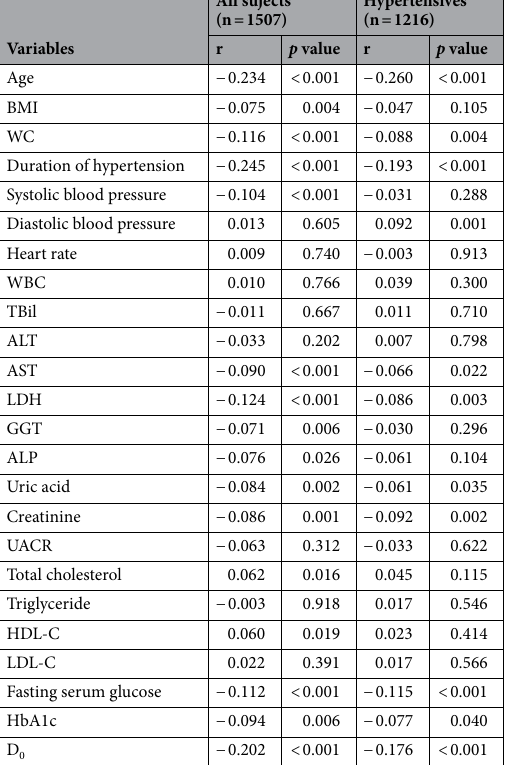
Table 2. Correlation of clinical profile and FMD in all subjects and hypertensives. FMD flow-mediated dilation; BMI body mass index; WC waist circumference; WBC white blood cell counts; TBil total bilirubin; ALT alanine aminotransferase; AST aspartate aminotransferase; LDH lactate dehydrogenase; GGT gamma glutamyl transpeptidase; ALP alkaline phosphatase; UACR urinary albumin to creatinine ratio; HDL-C high- density lipoprotein-cholesterol; LDL-C low-density lipoprotein-cholesterol; HbA1c glycosylated hemoglobin;